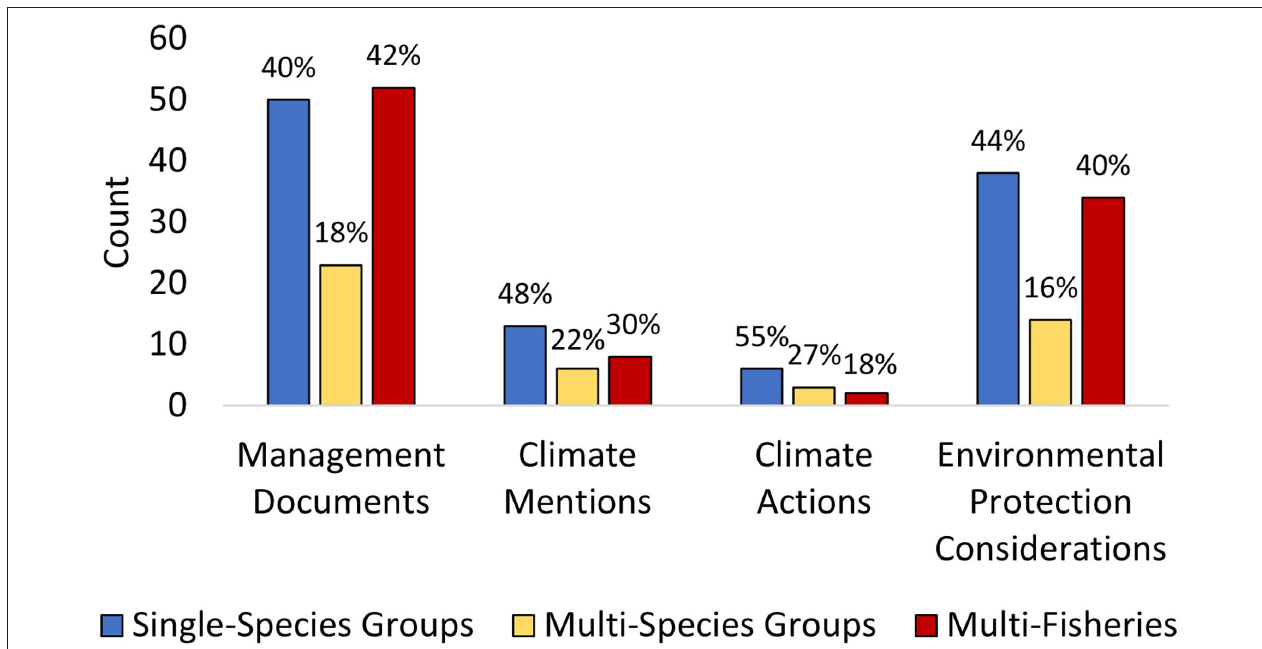
FIGURE 5 | The numbers (and proportions) of Management Documents, Climate Mentions, Climate Actions, and Environmental Protection Considerations for (1) Single-Species Groups, (2) Multi-Species Groups, and (3) Multi-Fisheries.